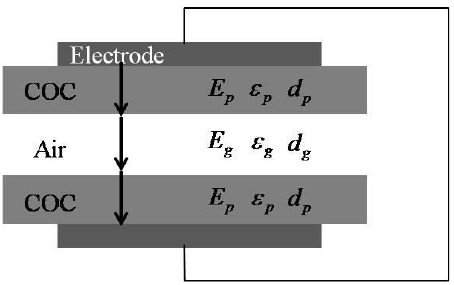
Figure 8. Simplified model for calculating breakdown voltage.